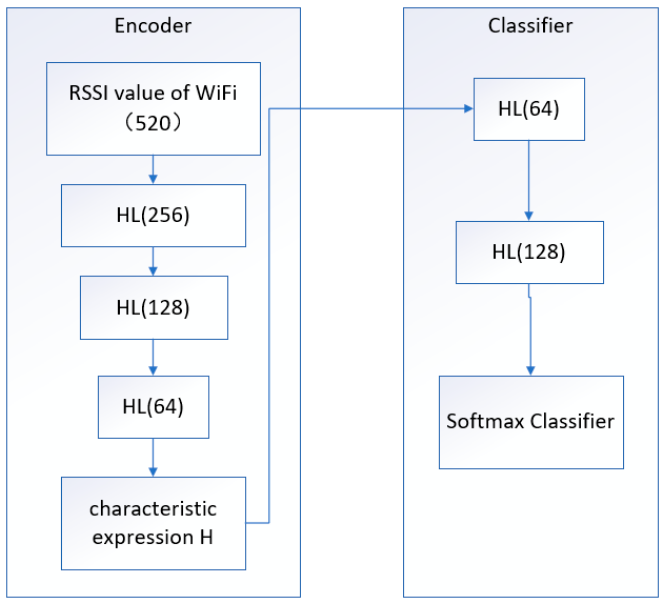
Figure 5. DNN classifier with SAE. SAE is responsible for dimensionality reduction processing, and DNN is responsible for completing the positioning task.